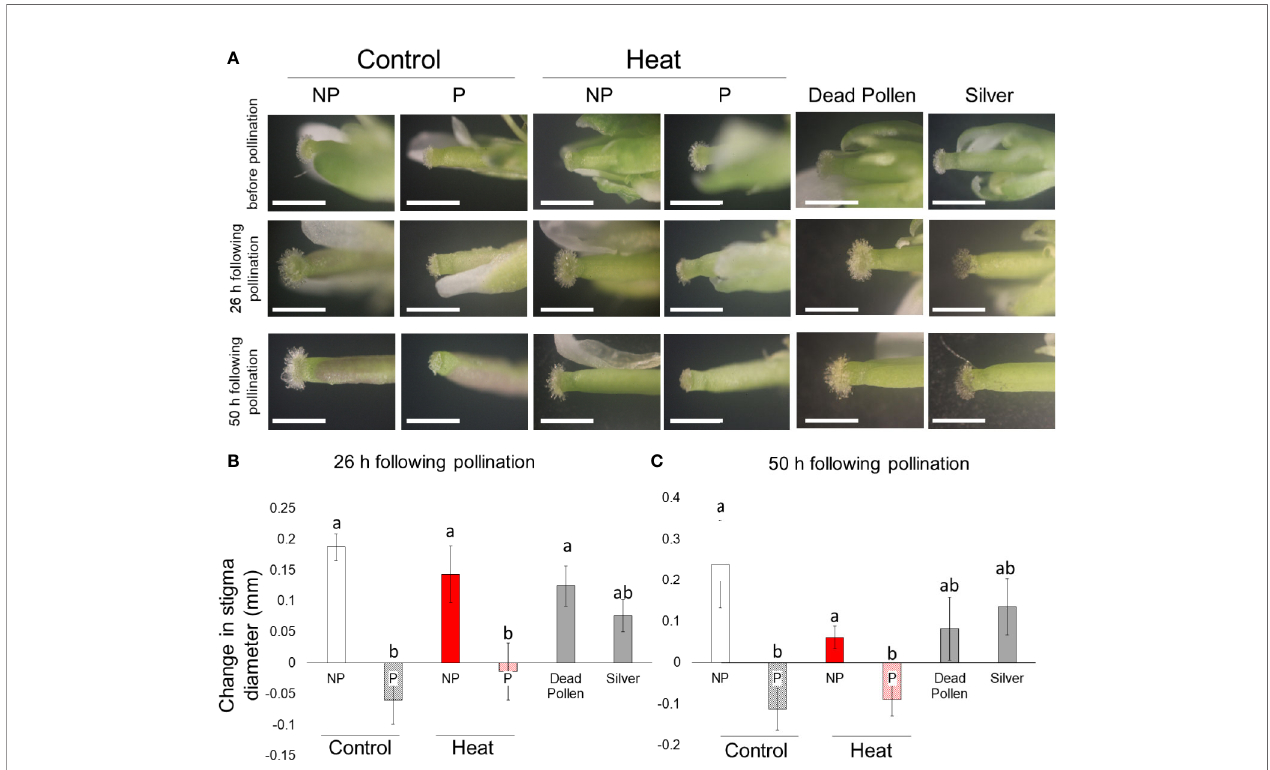
FIGURE 4 | Effects of arti fi cial pollination on stigma diameter in fl owers of Arabidopsis plants (Columbia-0) under controlled or heat stressed conditions. Columbia-0 plants also used as Pollen donor plants. (A) Photographs of stigmas before and after arti fi cial pollination. NP, no pollen on the stigma; P, pollen on the stigma. Dead pollen and silver nano particles also attached to the stigma as mechanical controls. Scale bars indicate 1 mm. (B) Change in stigma diameter at 26 h after arti fi cial pollination and (C) 50 h after arti fi cial pollination compared to that before arti fi cial pollination under controlled or heat stressed conditions. Bars indicate Standard error. Two-way ANOVA followed by Tukey's test was performed (n=5). Values statistically different at P<0.05 are denoted with different letters (a and